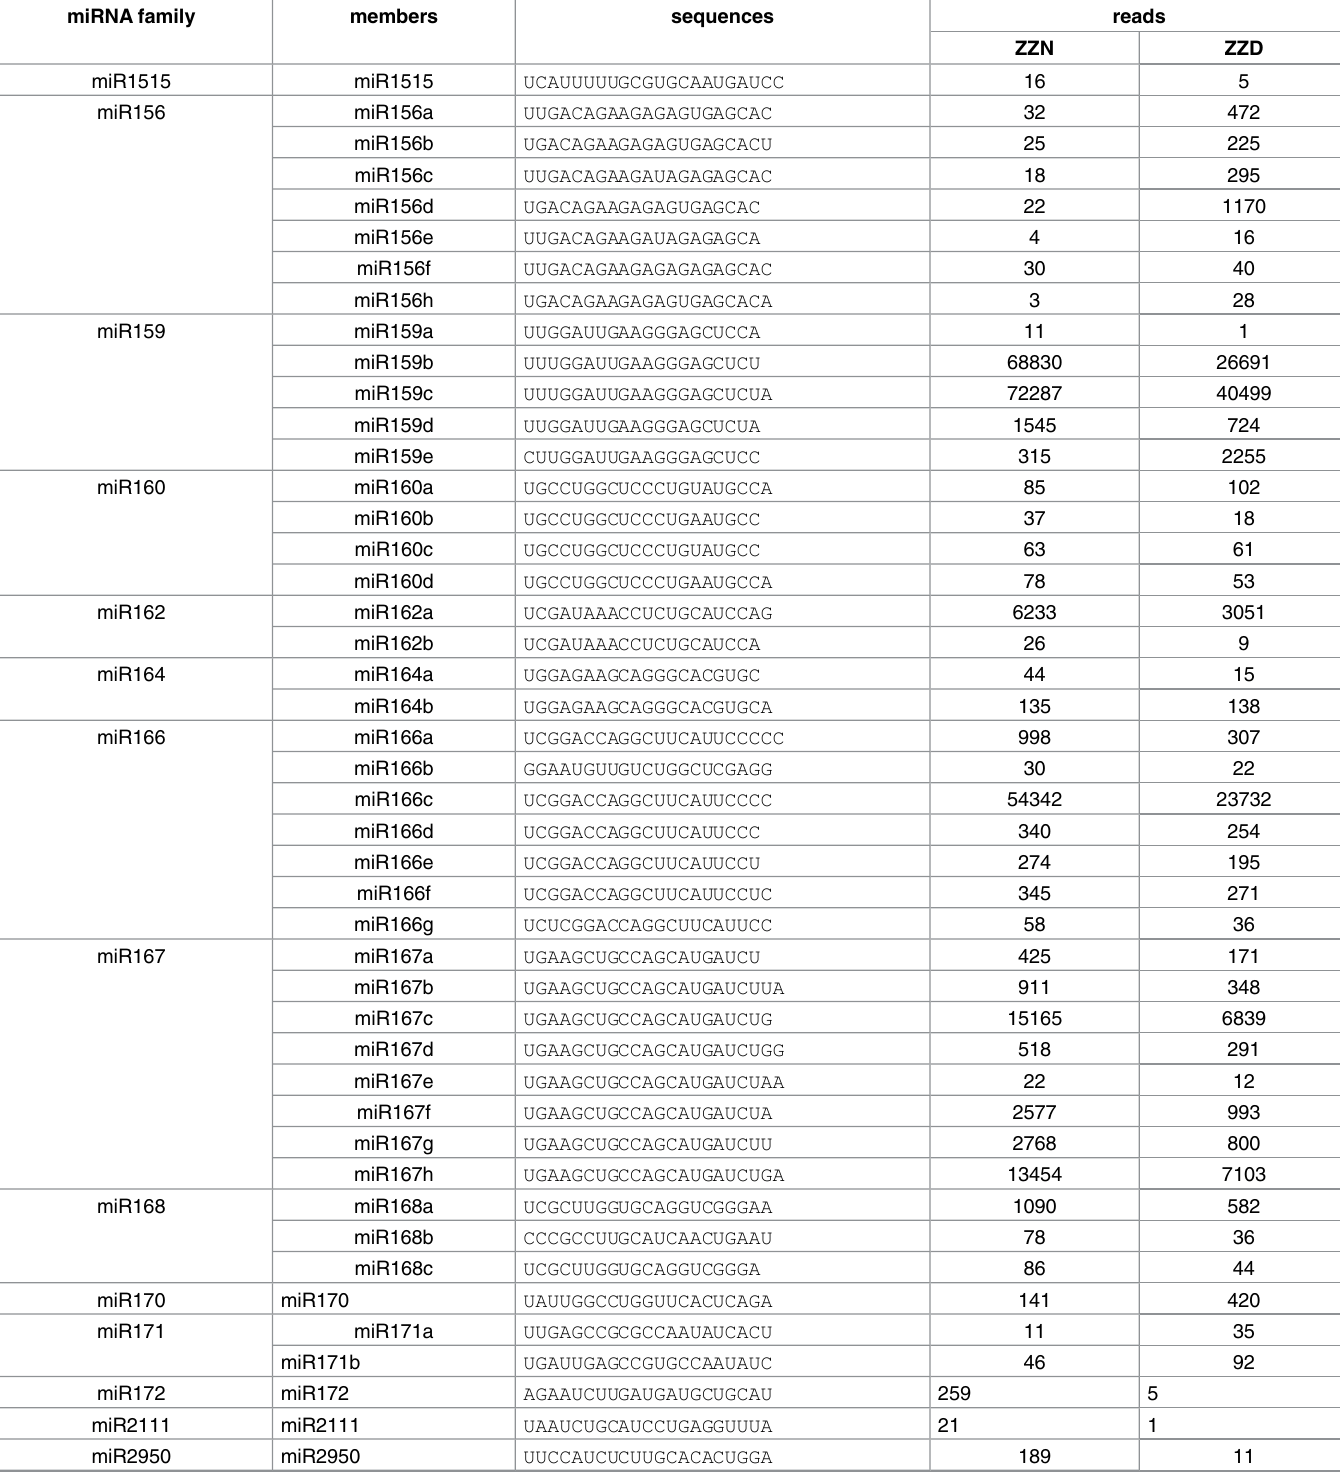
Table 2. The conserved miRNAs of Z . jujuba . miRNA family members